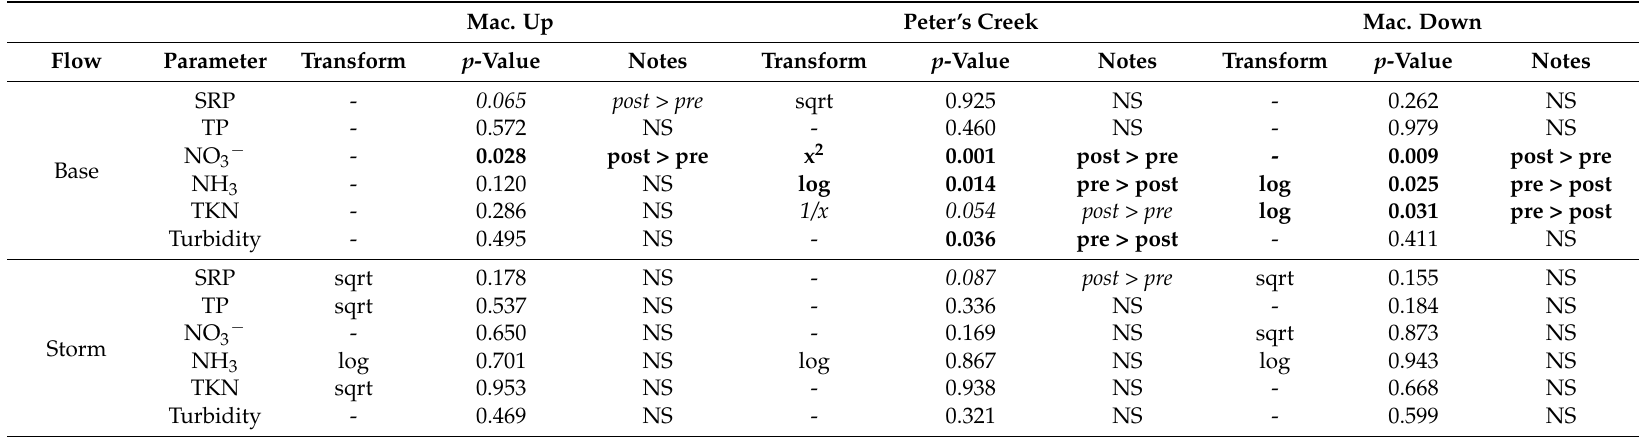
Table 6. Pre- vs. postrestoration statistical analyses of water quality at Middle Macatawa sites at baseflow and storm flow. To remove potential bias of pre- vs. postrestoration samples collected from different time periods, baseflow tests incorporated an equal number of samples from identical months in multiyear pre- and postrestoration periods (Apr., Jun., Jul., Sep., Oct., Nov., Dec., Jan., Feb., Mar., Apr., May, Jun., Jul., Aug., Sep.). Storm flow tests incorporated all possible sampled storm